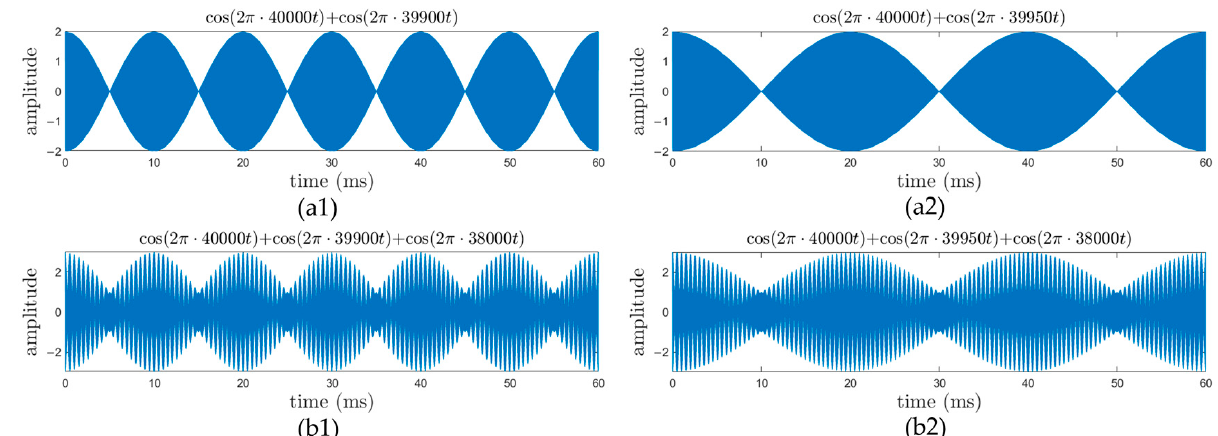
Figure 17. The illustration of TFCW waveforms ( a1 ) Before period extension and ( a2 ) After period extension, and MFCW waveforms ( b1 ) Before period extension and ( b2 ) After period extension. achieved a less than 0.0711 mm 3 σ error (i.e., δ R < 0.024 mm) when R < 0.1 m (for most TOF-based pMUT rangefinder systems, δ R are not less than 0.4 mm) [35]. Although